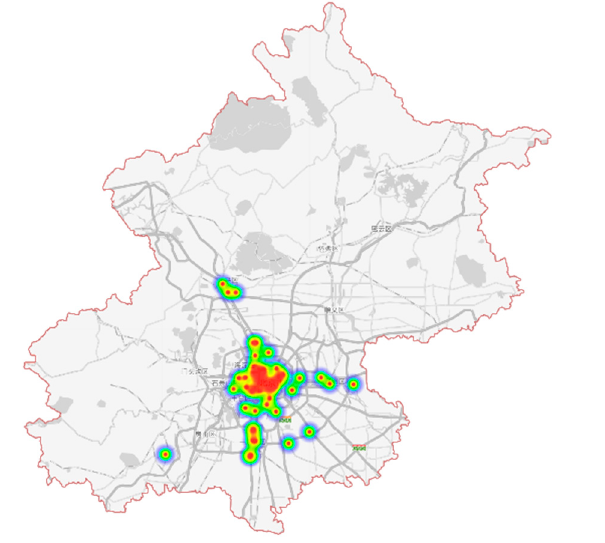
Figure 11. ( a ) Heat map of the geographic distribution of user markers (before the outbreak); ( b ) heat map of the geographic distribution of user markers (during the outbreak).